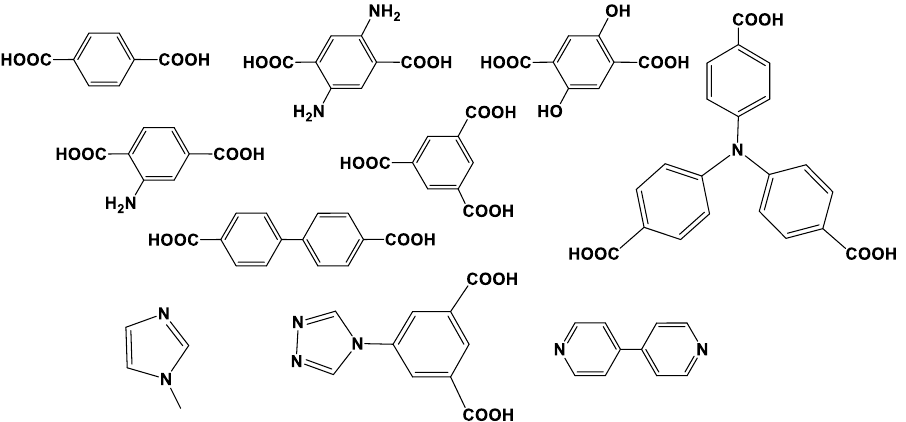
Figure 1. Chemical structures of the linkers applied for assembling the MOF materials.